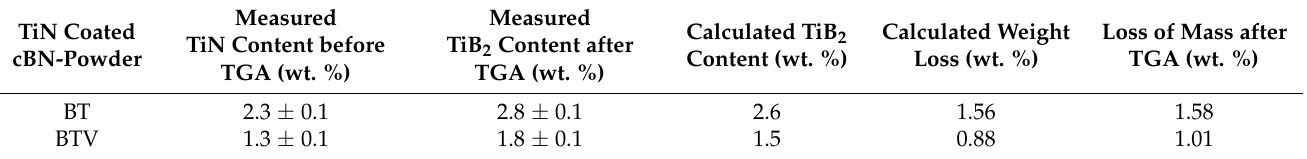
Table 3. By XRD analysis measured and calculated phase contents of TiN and TiB 2 in the initial and in the Ar heat-treated cBN powders and measured and calculated weight loss during heat treatment according to reaction (1) and (2). Measured TiN Coated cBN-Powder